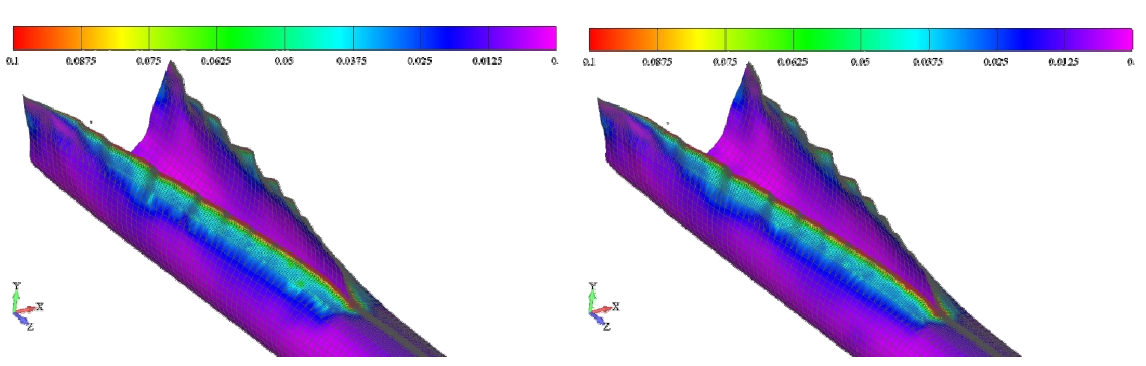
Figura 15: Andamento della deformazione totale nel tubo in due step di calcolo